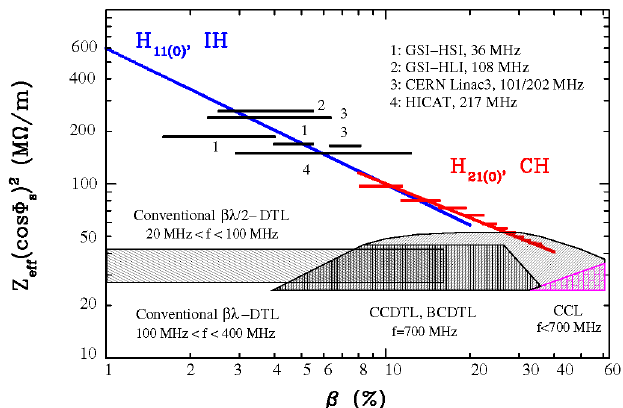
FIG. 3. (Color) Effective shunt impedance for different rf struc- tures including the transit time factor T and the synchronous phase (cid:3) as a function of the particle velocity (cid:1) (cid:1) v=c . The black horizontal bars represent some existing IH-DTLs [13,21,22] and the red bars represent the expected shunt imped- ance of the rt CH cavities for the GSI-FAIR 70 MeV, 70 mA proton linac [57].